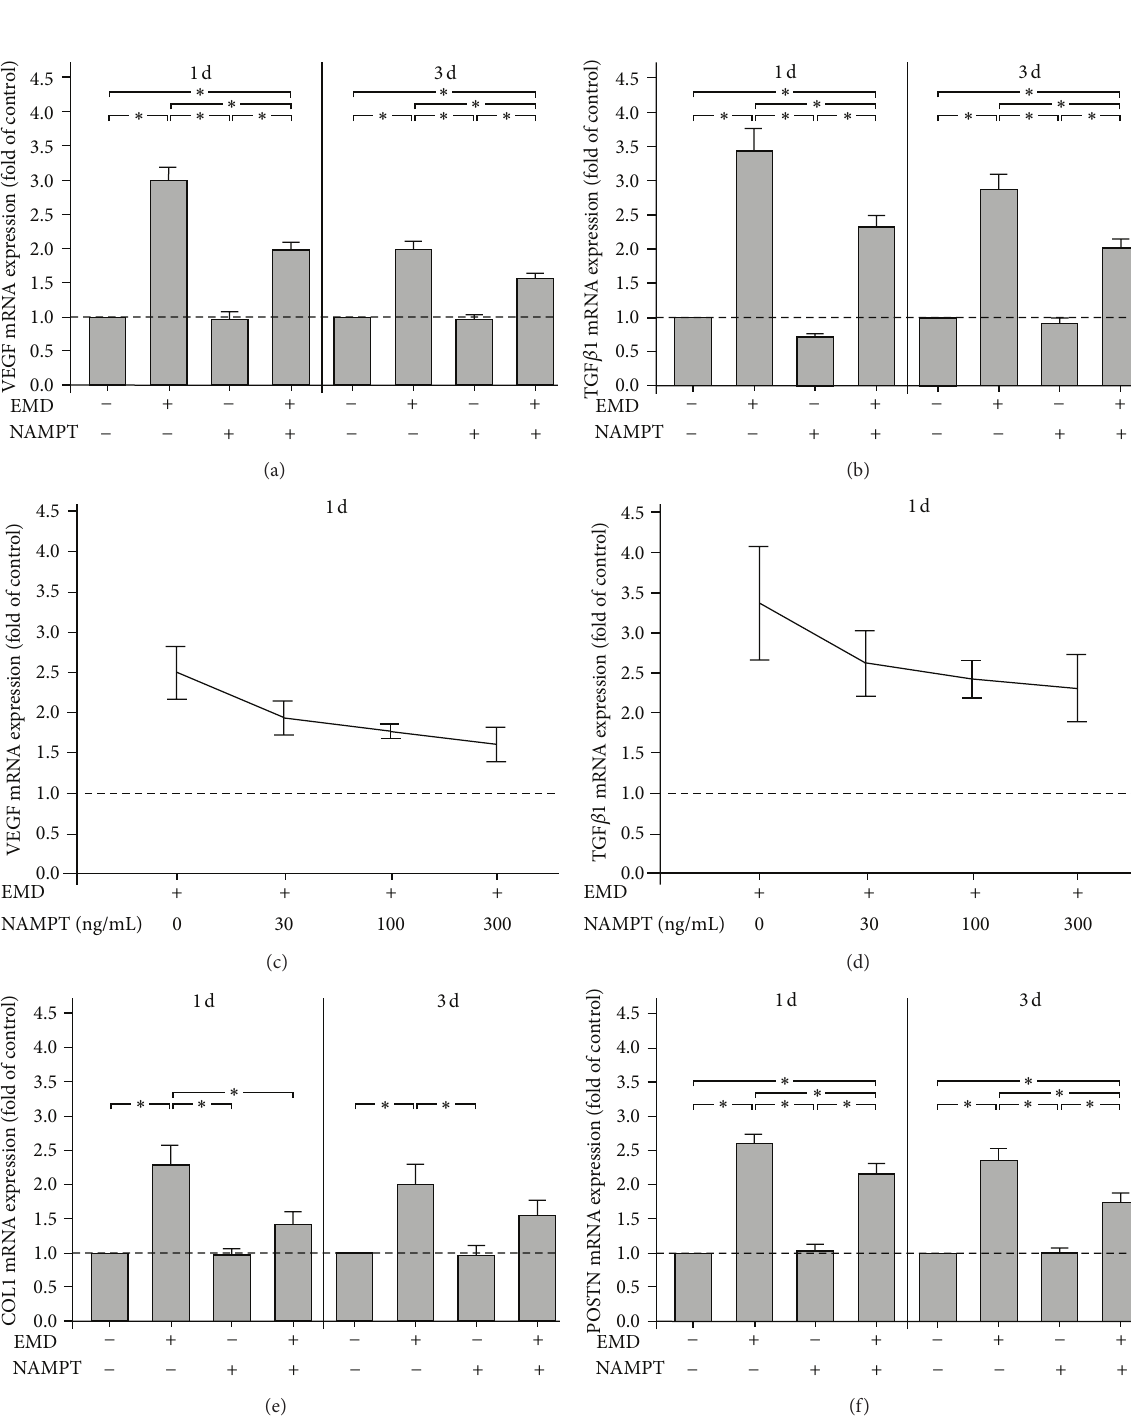
Figure 2: Effect of EMD on the VEGF (a), TGF 𝛽 1 (b), COL1 (e), and POSTN (f) mRNA expressions in the presence and absence of NAMPT (100ng/mL) at 1d and 3d. Untreated cells served as control. All experiments were performed in triplicate and repeated at least twice. Mean ± SEM ( 𝑛 = 18 ); ∗ significant ( 𝑃 < 0.05 ) difference between groups. Effect of various concentrations (0, 30, 100, and 300ng/mL) of NAMPT on the VEGF (c) and TGF 𝛽 1 (d) mRNA expressions in EMD-treated cells at 1d. All experiments were performed in triplicate and repeated at least twice. Mean ± SEM ( 𝑛 = 9